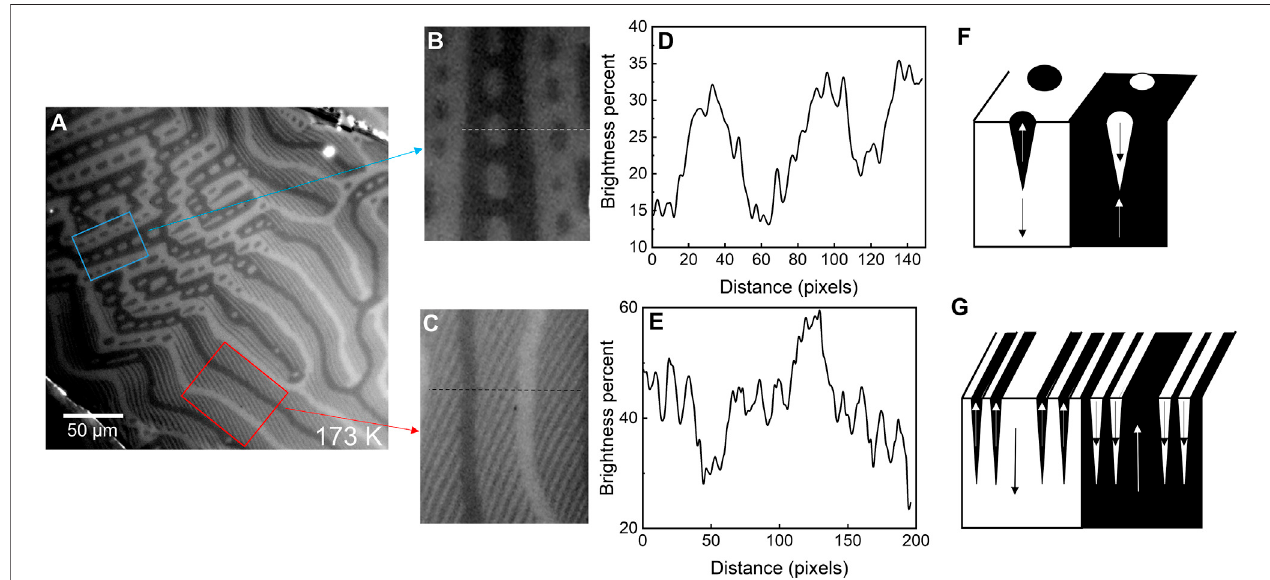
FIGURE 2 | (A) Represented image of the magnetic domains of DyMn 6 Sn 6 crystal at 173 K. (B) Type-I domains in DyMn 6 Sn 6 . (C) Type-II domains in DyMn 6 Sn 6 . (D,E) Correspondingmapofthebrightnessdistributionintwotypesofmagneticdomains. (F,G) Correspondingsketchmapoftwotypesofmagneticdomainsstructure.